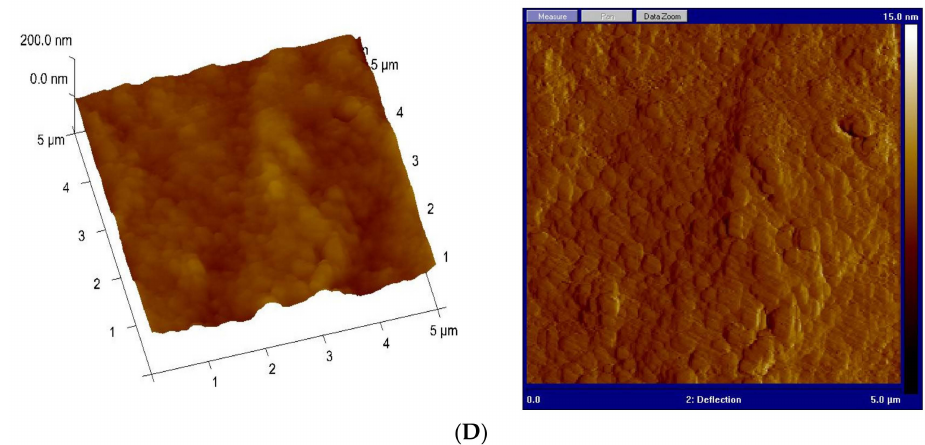
Figure 8. The 2d and 3d Atomic force microscopy (AFM) micrographs of mild steel surface in 1.0 M HCl solution in the absence ( A ) and presence of 5 × 10 − 3 M of BMPyrIM ( B ), BMImIM ( C ) and BBMImIM ( D ) after 24 h